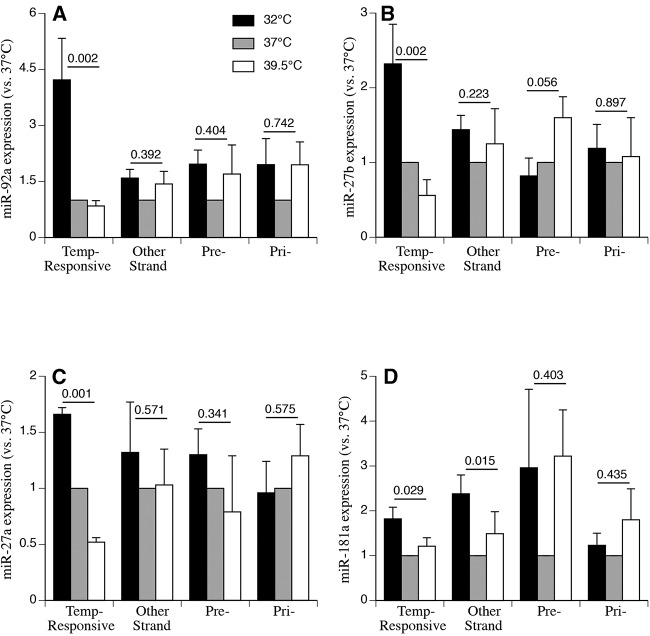
Quantitative RT-PCR analysis of temperature effects on pri-miRNA, pre-miRNA, and opposite strand expression pattern in human SAECs. Human SAECs from two lots were incubated for 24 h at 32°C, 37°C, or 39.5°C without rhTNFα. Total RNA was collected and levels of the temperature-responsive strand, the sister strand, the pri-miRNA, and the pre-miRNA for (A) hsa-miR-92a-1, (B) hsa-miR-27b, (C) hsa-miR-27a, and (D) hsa-miR-181a were analyzed by qRT-PCR as described in Materials and Methods and are expressed relative to expression of each in 37°C hSEAECs. Mean ± SEM, n = 4. The P-values from one-way ANOVA are indicated.